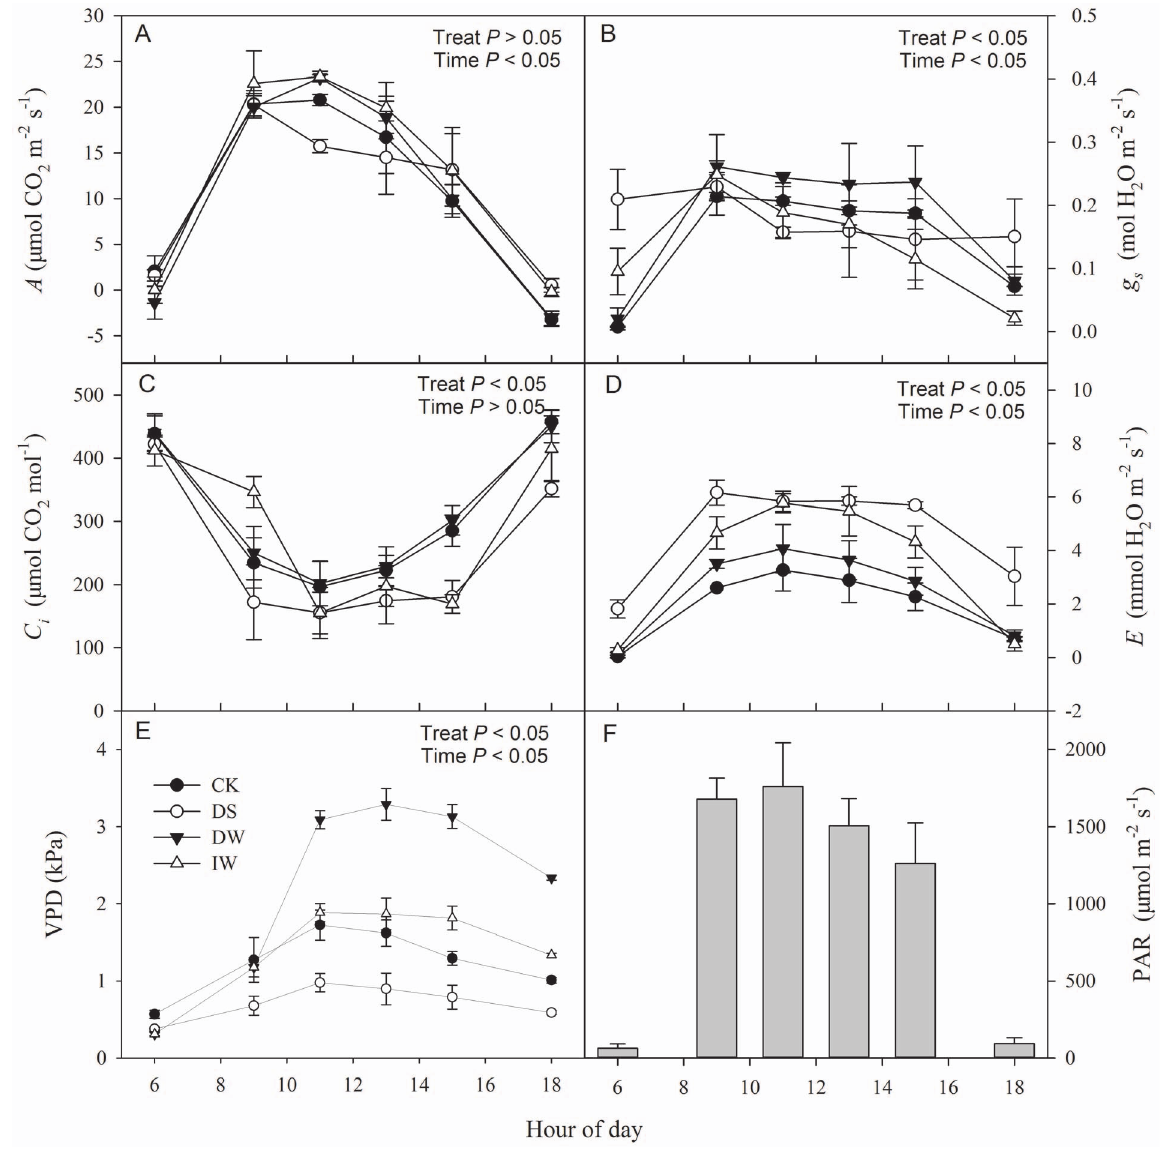
Figure 6. Diurnal changes in (A) assimilation rate ( A ), (B) stomatal conductance ( g s ), (C) intercellular CO 2 concentration ( C i ), (D) transpiration rate ( E ) and (E) atmospheric vapour pressure deficit (VPD) (mean ± SE) in winter wheat under four treatments (CK, DS, DW and IW), as well as (F) photosynthetic photon flux density (PAR) in jointing stage. P value represent the significance of the effects of each